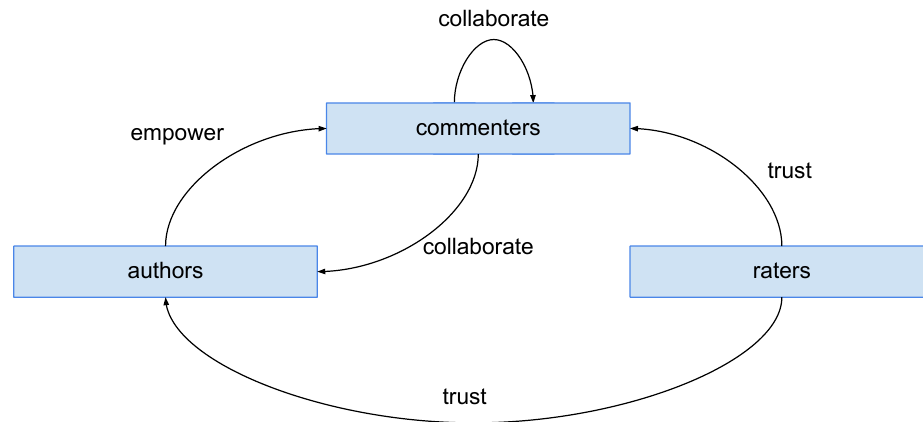
Figure 3. Co-workers roles and actions in the enterprise social